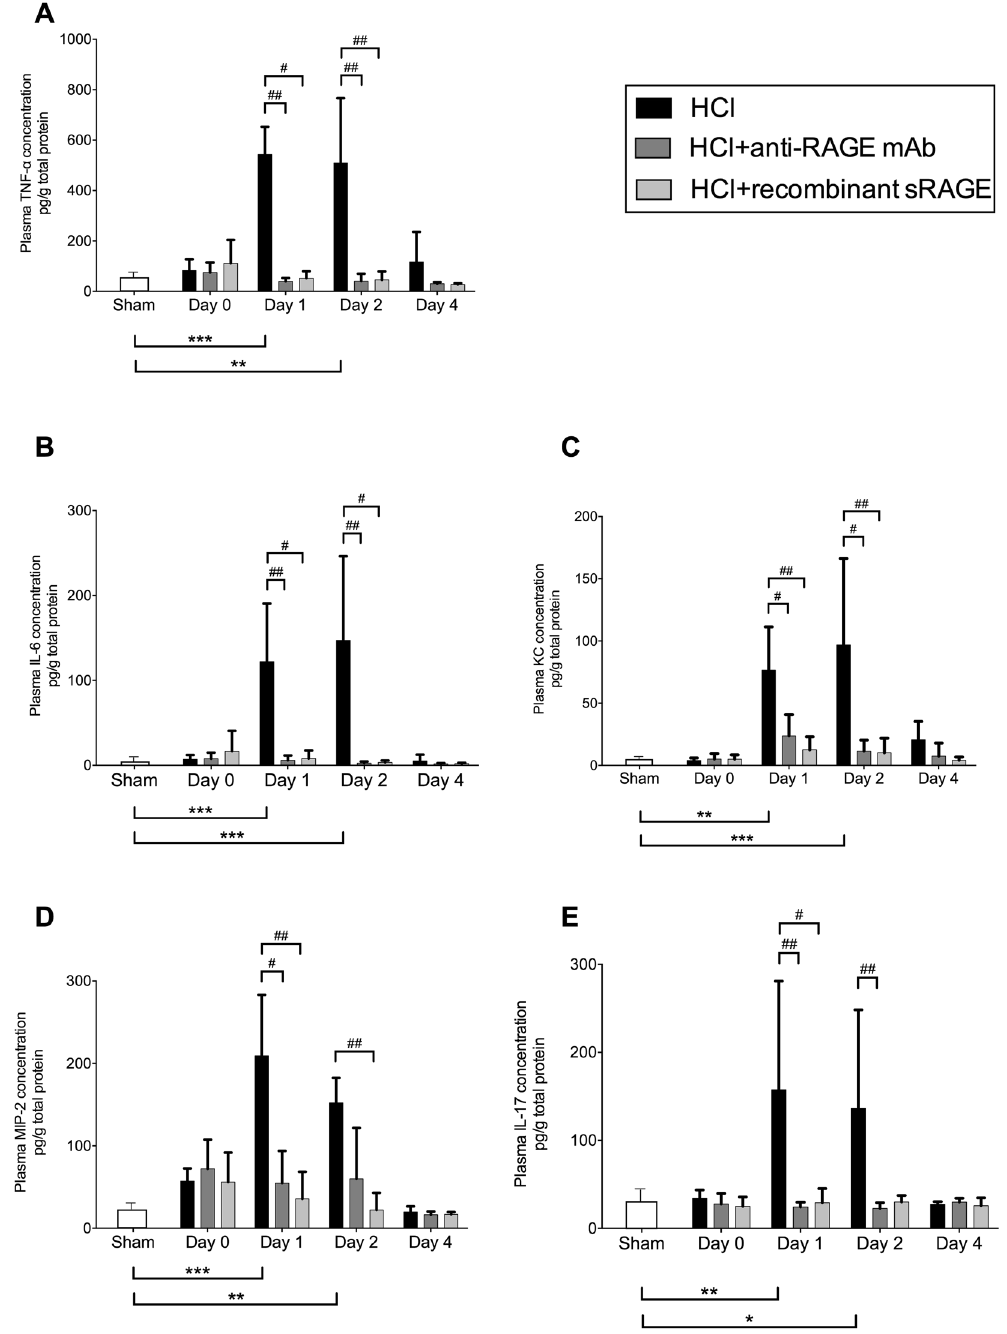
Figure 5. Anti-inflammatory effects induced by RAGE inhibition. Measurement of plasma levels of (A) TNF- α , (B) IL-6, (C) KC, (D) MIP-2 and (E) IL-17 in uninjured, untreated mice (Sham group), acid-injured animals (HCl group) and acid-injured animals treated with sRAGE (HCl + recombinant sRAGE group) or with anti-RAGE monoclonal antibody (HCl + anti-RAGE mAb group) (n = 4–6 for each time-point). Levels of cytokines were normalised to those of total protein. As no difference was observed between sham animals at all time points; the results from sham mice were mixed for analyses (left bar of the X-axis). Values are reported as means ± standard deviations. * P < 0.05; ** P < 10 − 2 ; *** P < 10 − 3 versus sham controls; # P < 0.05; ## P < 10 − 2 versus acid-injured